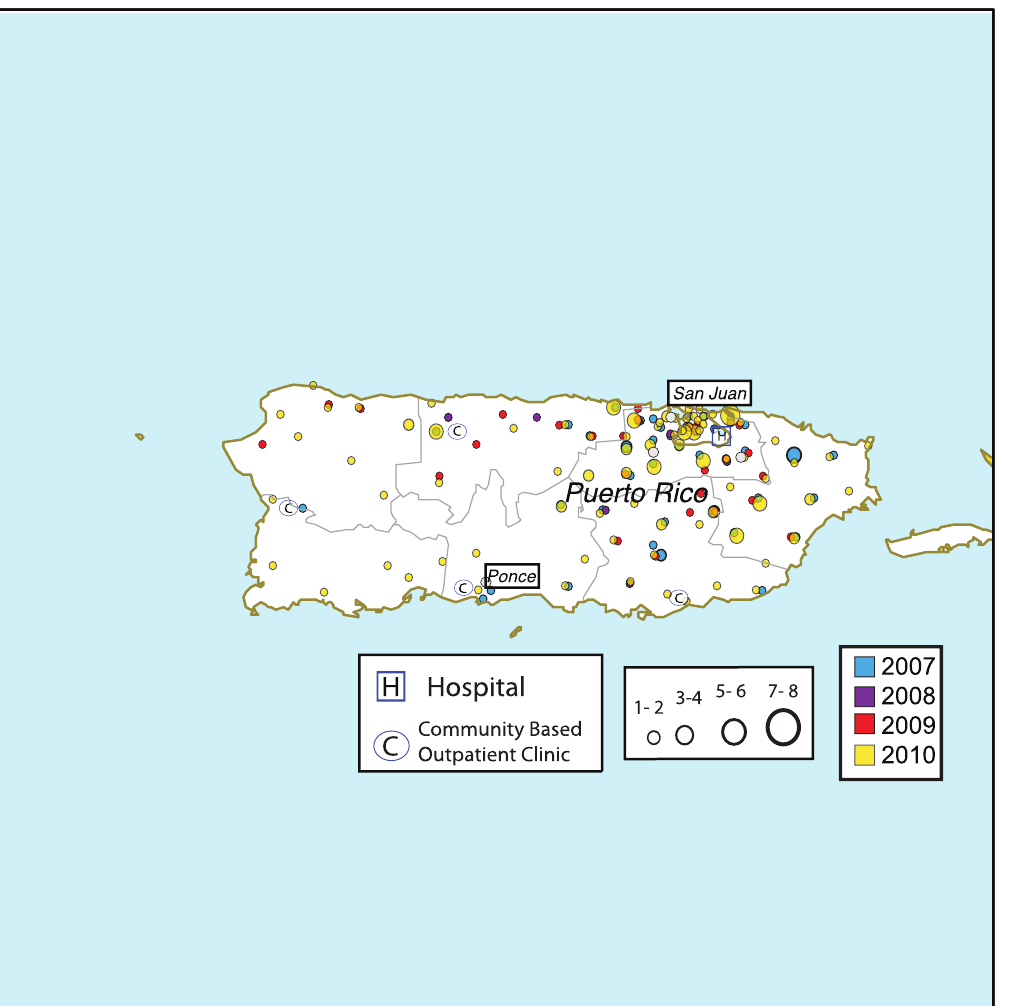
Figure 1. VA dengue cases in Puerto Rico. Location of dengue cases (confirmed/probable/suspected) presenting to Puerto Rico VAs based on zip code of residence, 2007–2010.